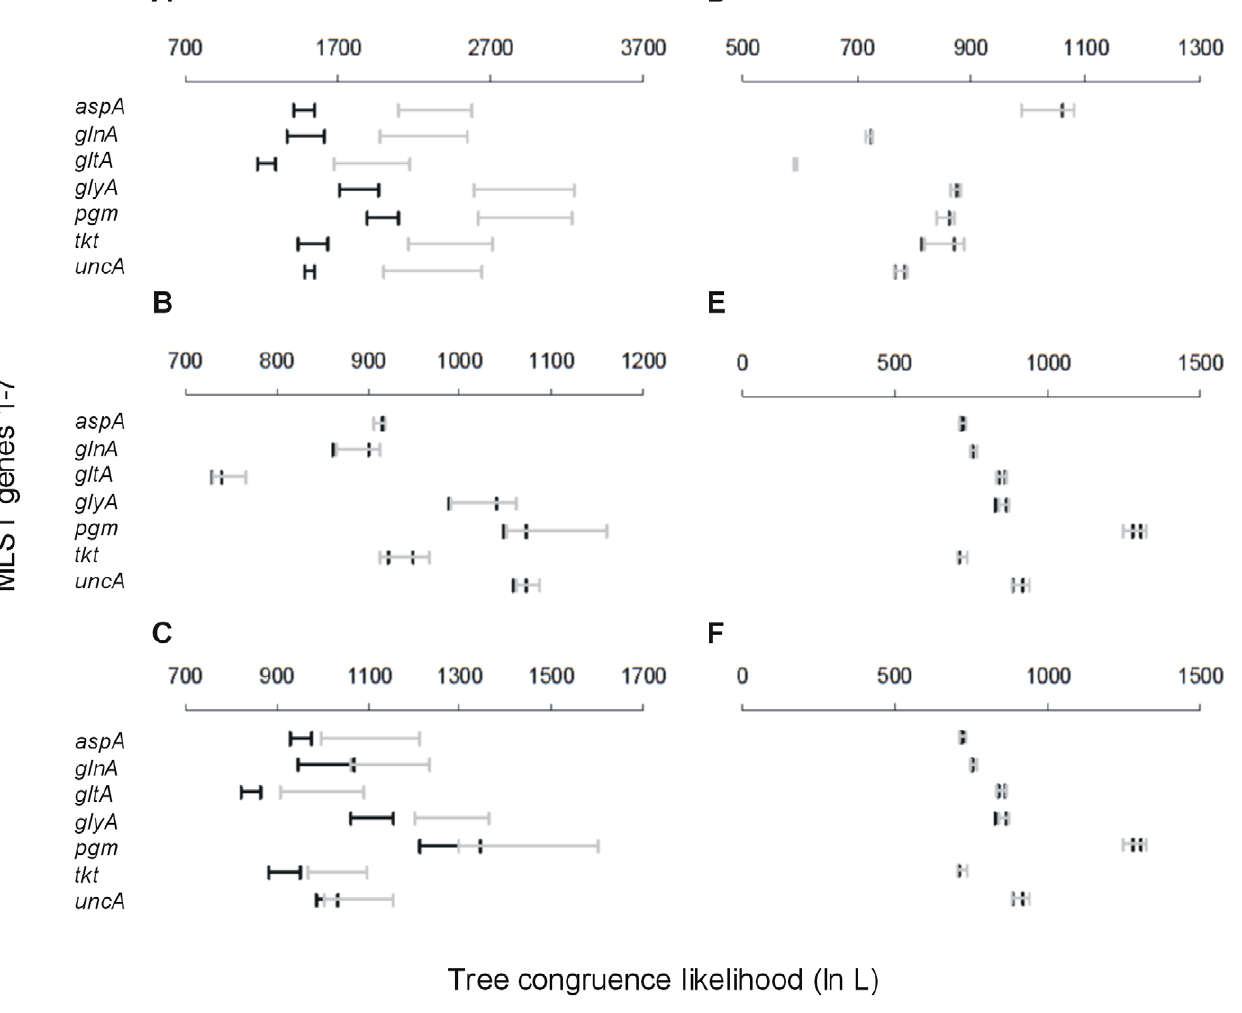
Figure 2. Maximum likelihood (ML) analysis of congruence in Campylobacterjejuni and Campylobactercoli . The ML tree of each MLST locus is compared with the ML trees from the other six loci for: (A) C. coli clades 1–3, (B) C. jejuni , (C) C. coli and C. jejuni (D) C. coli clade1, (E) C. coli clade 2 and (F) C. coli clade 3. The tree congruence likelihood (ln L) range is shown with horizontal bars for each locus (black) and for 200 trees of random topology (grey) for aspA , glnA , gltA , glyA , pgm , tkt and unc respectively from top to bottom on each graph. If the ln L range falls outside the range calculated for random trees there is more congruence among the ML trees than expected by chance. doi:10.1371/journal.pone.0015708.g002 PLoS ONE |